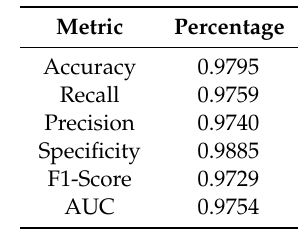
Table 6. Classification results based on testing